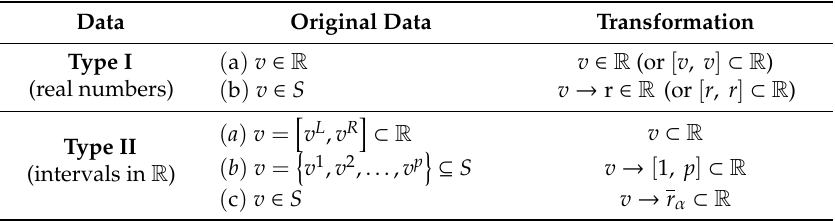
Table 1. Types of